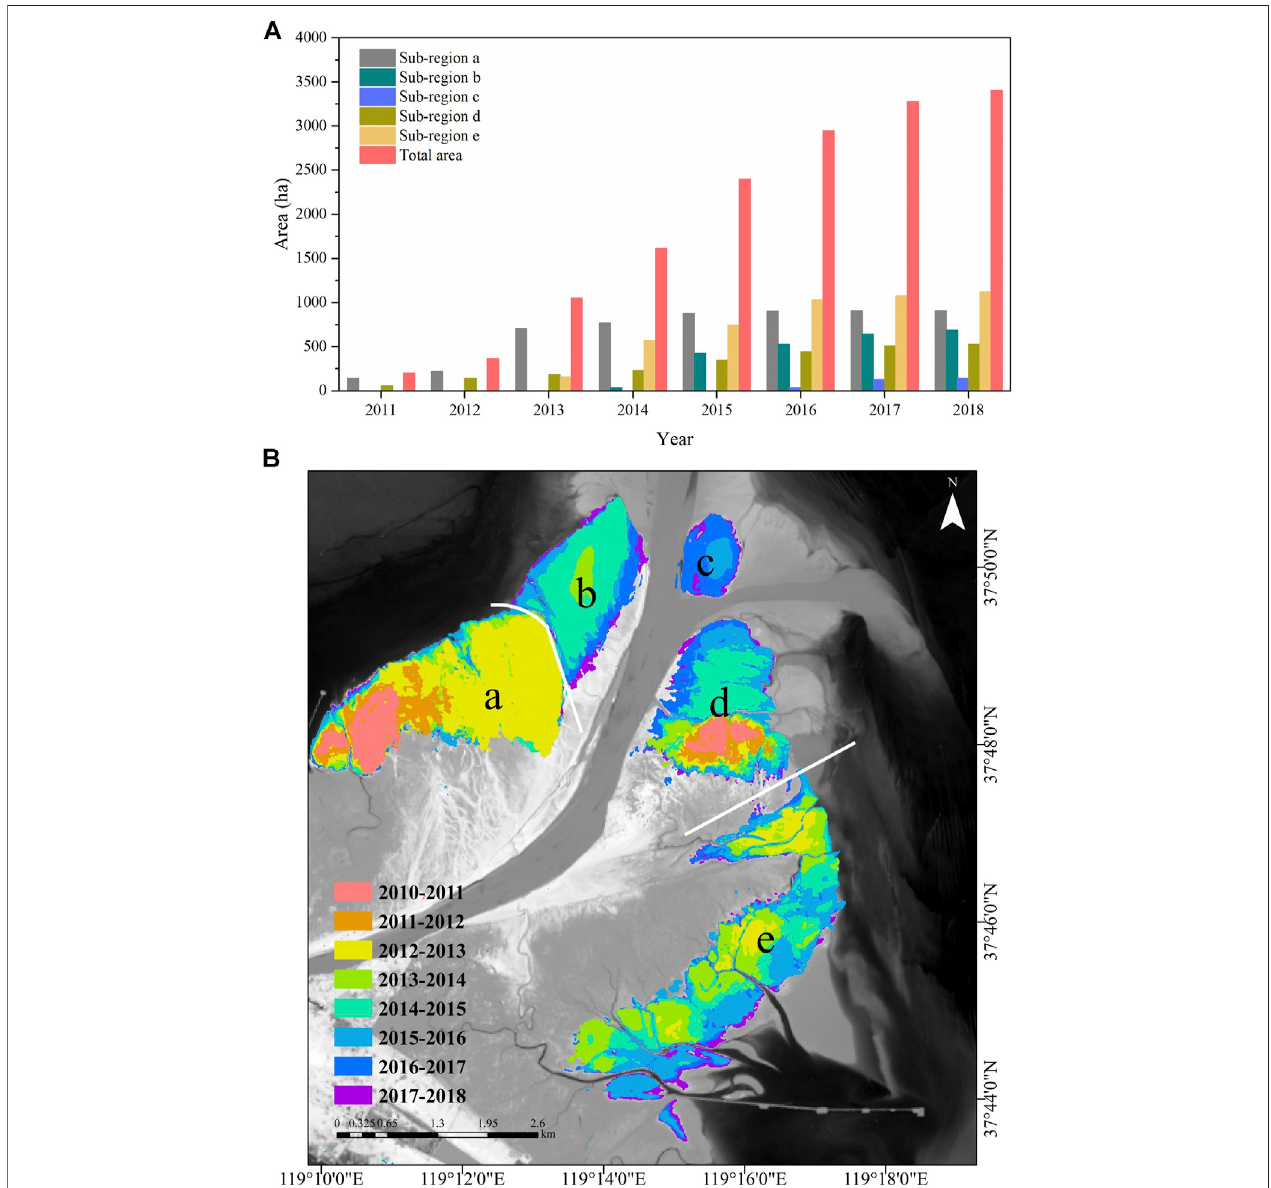
FIGURE3|(A) TemporalevolutionofS.alterni fl oracoverareafortheentireYellowRiverEstuaryandthesub-regionsfrom2011to2018and (B) Spatialvariationof S. alterni fl ora at the Yellow River Estuary from 2011 to 2018.